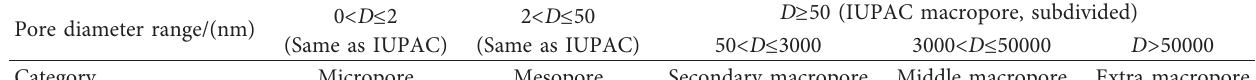
Table 2: Pore types boundary based on pore diameter D.